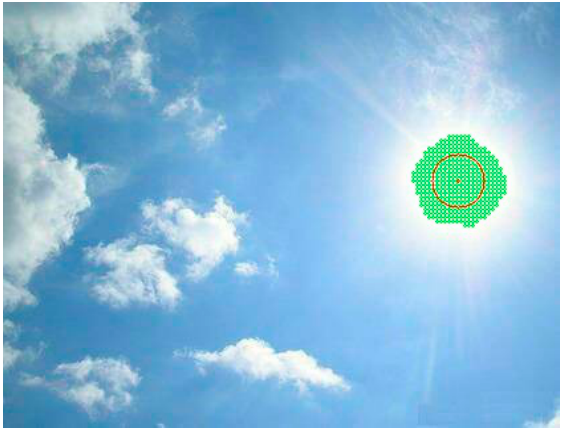
Figure 4. The green points have the maximum gray level value of 255. The red point is found by the arithmetic average of the x and y coordinates of the green points, respectively.